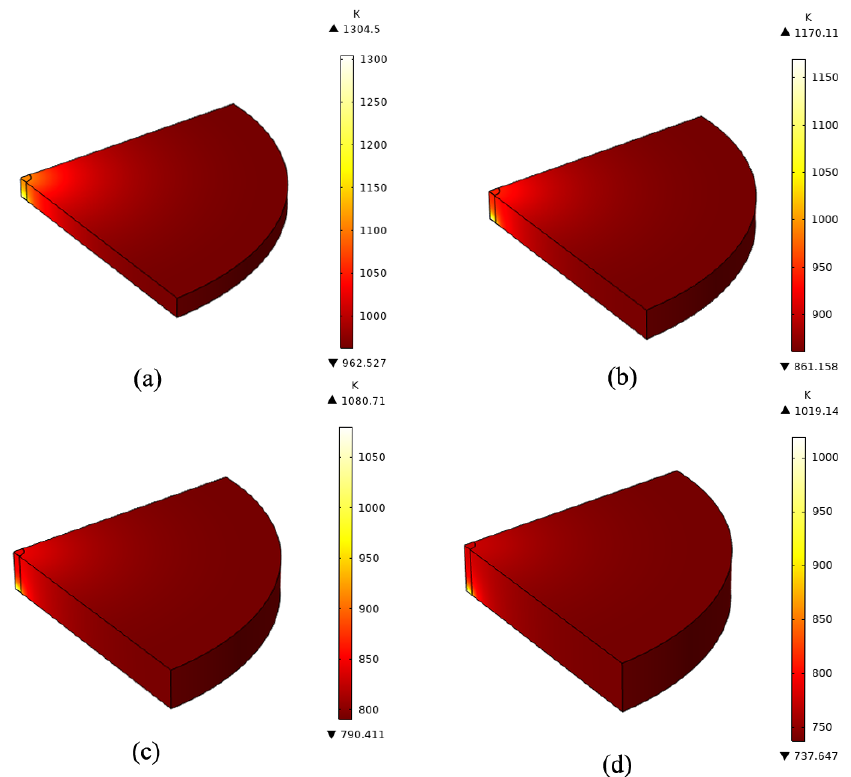
Figure 5. ( a – d ) are the temperature changes in the center of silicon wafers with different thicknesses (2 mm, 3 mm, 4 mm, 5 mm) at the end of continuous laser beam irradiation for 60 s, respectively.